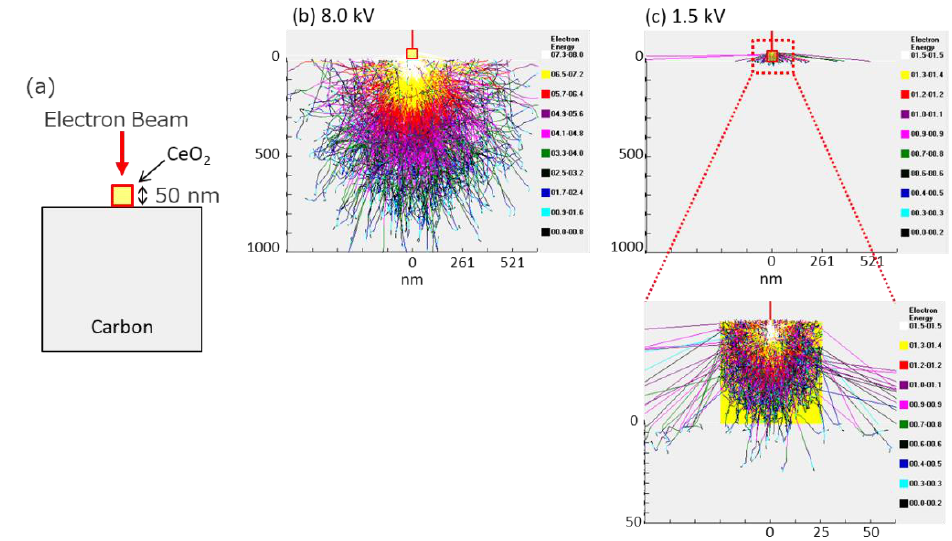
Figure 7. Calculation of electron penetration depth in 50 nm CeO 2 . ( a ) A schematic image of this simulation. ( b , c ) Results of simulations in different acceleration voltages, 8.0 kV, 1.5 kV.